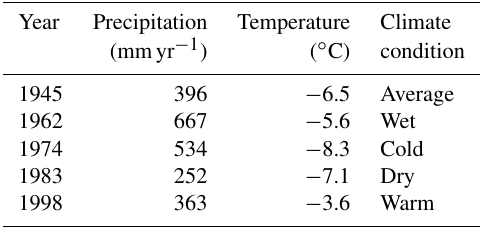
Table 1. Climate conditions of the 5 representative years used in this